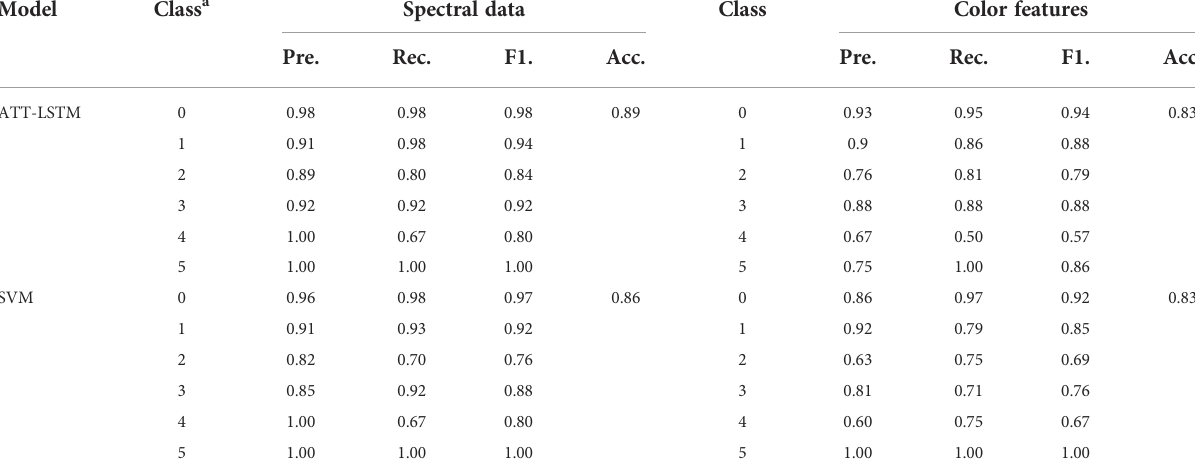
Model Class a Spectral data